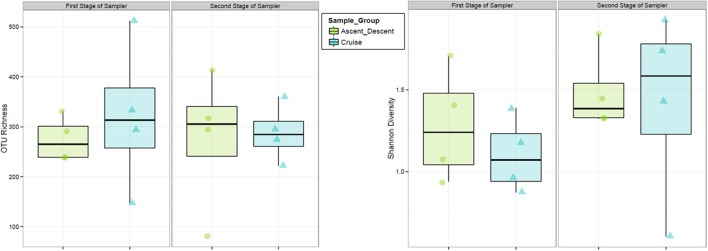
Relative abundance and diversity of flight samples (Ascent/Descent and Cruise) collected on the two internal stages of the ABC cascade sampler.